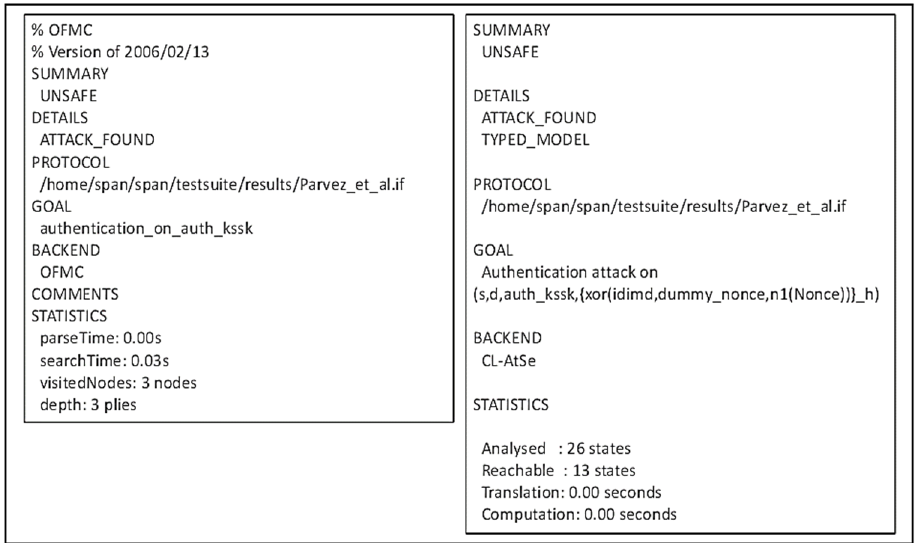
Figure 11. AVISPA result of Parvez et al.’s protocol.